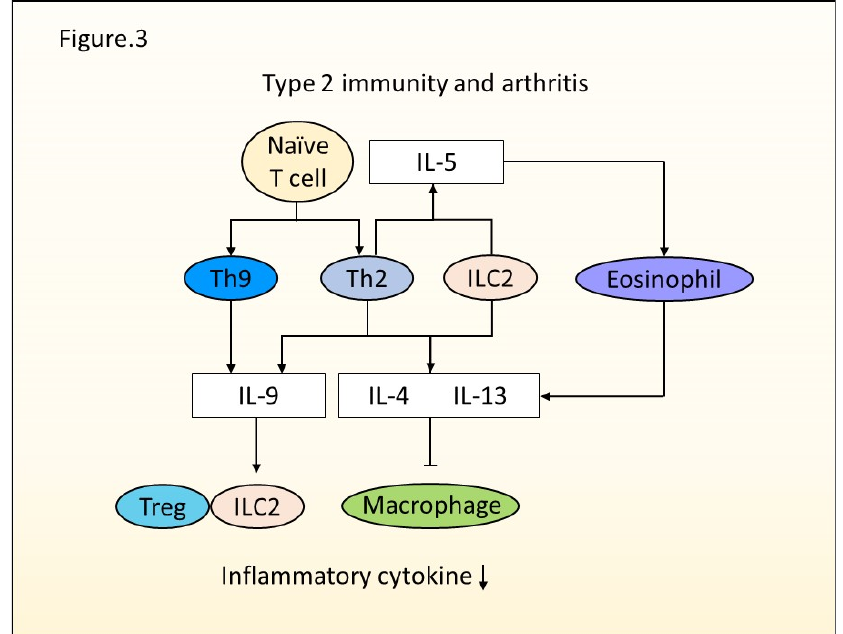
Figure 3. Type 2 immunity and arthritis. Naive T cells differentiate into Th2 cells by the activation of GATA3 genes. Th2 cells and ILC2s produce IL-4 and IL-13, which suppress macrophage activation in the inflammatory status. Th2 cells and ILC2s also secrete IL-5, activating eosinophils to generate IL-4 and IL-13. Naive T cell-derived Th2 and Th9 can produce IL-9. IL-9 enhances the interaction of ILC2s and Tregs to alleviate inflammation. ILC2s regulate both the initiation and resolution of arthritis.